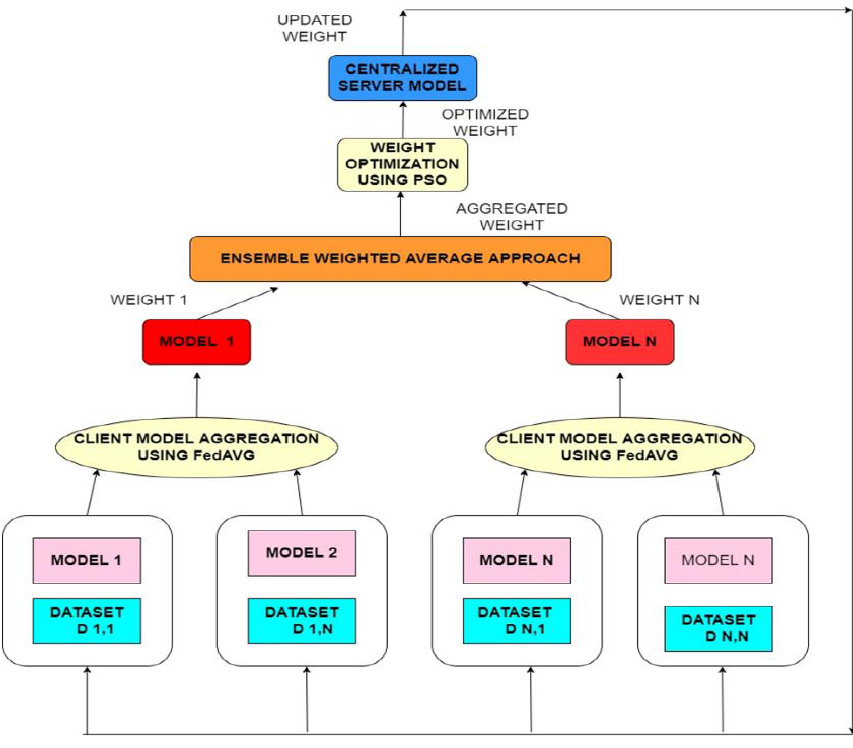
Figure 3. The proposed federated learning approach.